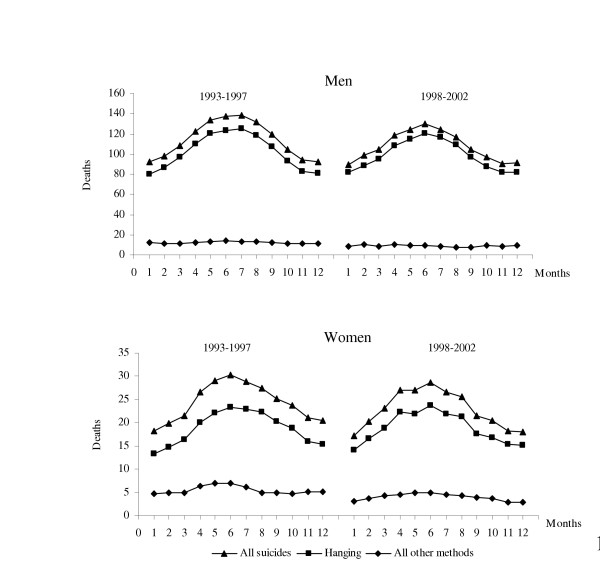
Smoothed trends in suicides.